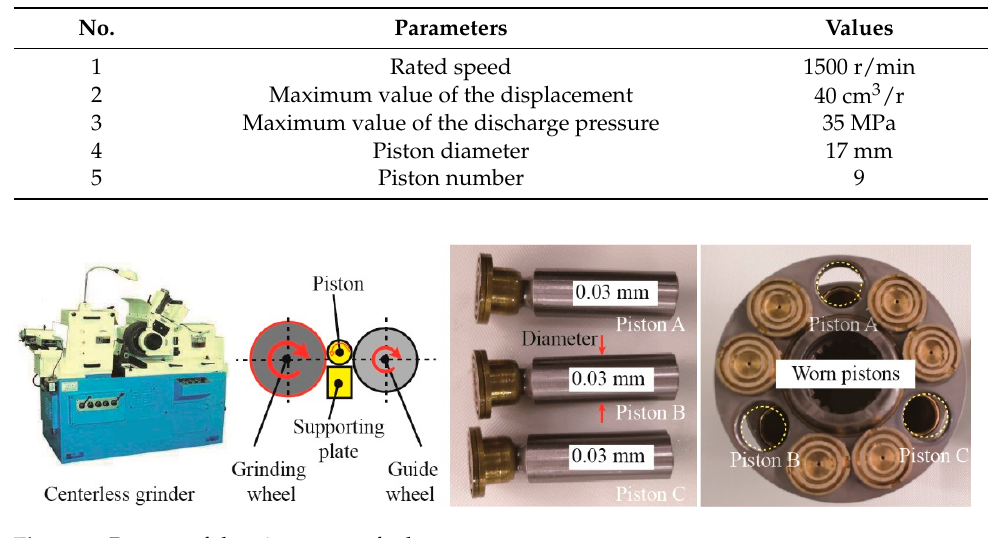
Figure 2. Process of the piston wear fault.